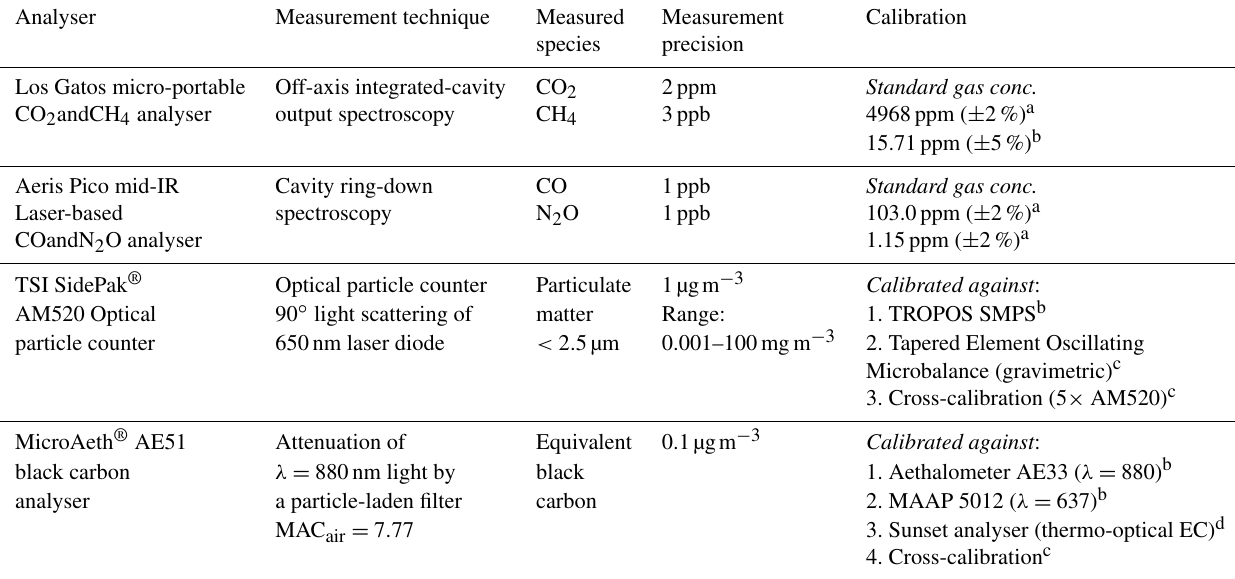
Table 1. Description of analysis equipment used for UAS measurements of EFs in biomass burning plumes. Analyser